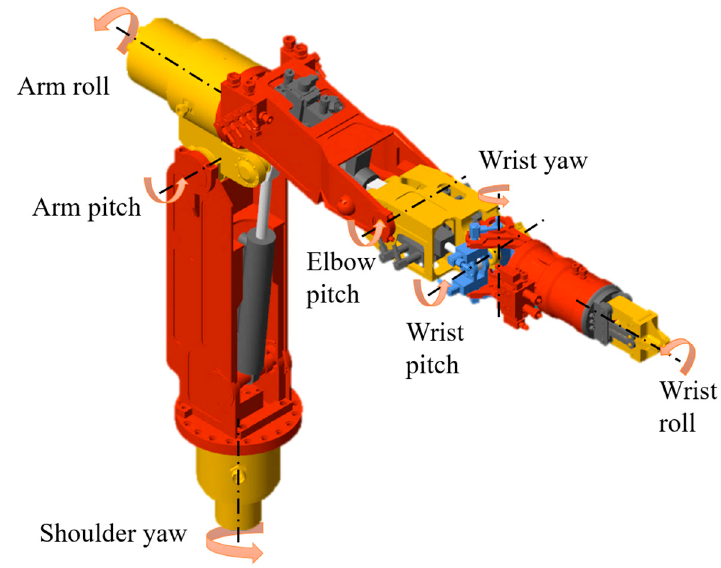
Figure 1. 7-degree-of-freedom (DOF) redundant hydraulic manipulator. Table 1. The D–H parameters of manipulator. Joint Number